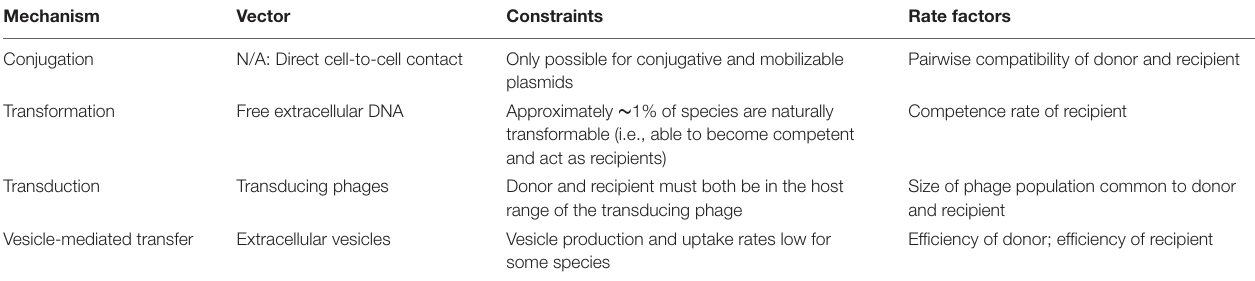
TABLE 1 | Four mechanisms of horizontal gene transfer. Mechanism Vector Constraints Rate factors